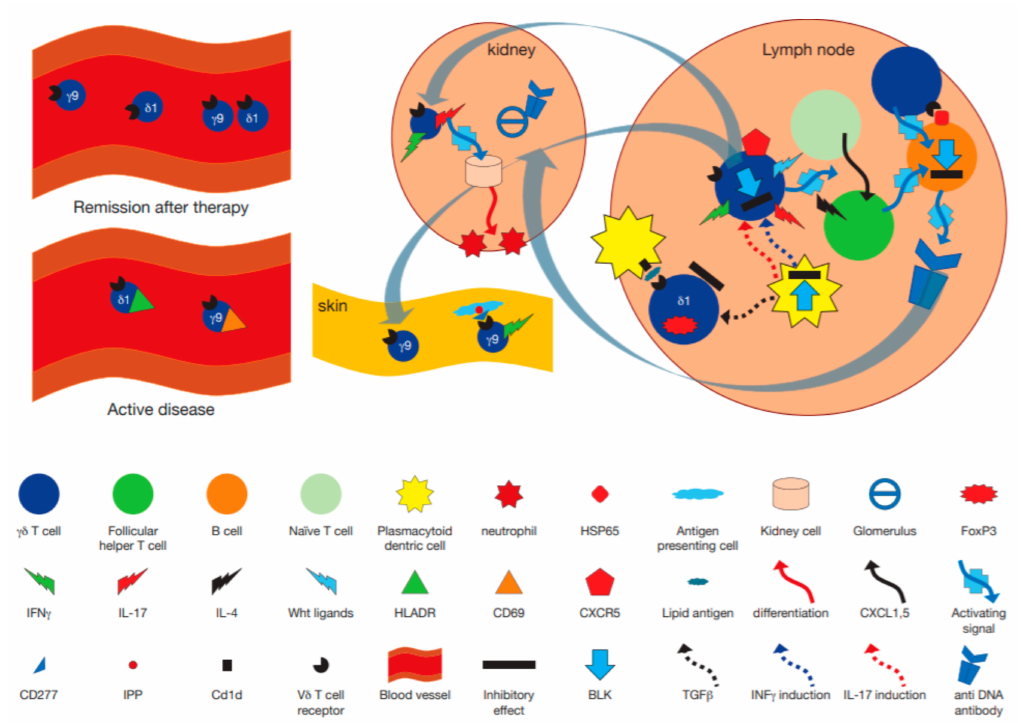
Figure 2. Hypothetical model incorporating the immunopathogenetic role of γδ T cells in human systemic lupus erythematosus (SLE) and murine models. γδ T cells may become activated by plasmacytoid dendritic cells pDC in lymph nodes, leading to their secretion of proinflammatory cytokines such as IL-17 and IFN γ , an activity modulated by BLK [93]. A subset of γδ T cells expressing CXCR5 release Wingless-related integration site (Wnt) proteins, that enhance di ff erentiation of naïve T cells to become follicular helper T cells [100], which in turn, together with IL-4 secretion [97] di ff erentiate B cells to become antigen producing cells making anti DNA antibodies. Other γδ T cells directly interact with heat shock protein (HSP)65 expressing B cells via their T cell receptor (TCR) and help drive